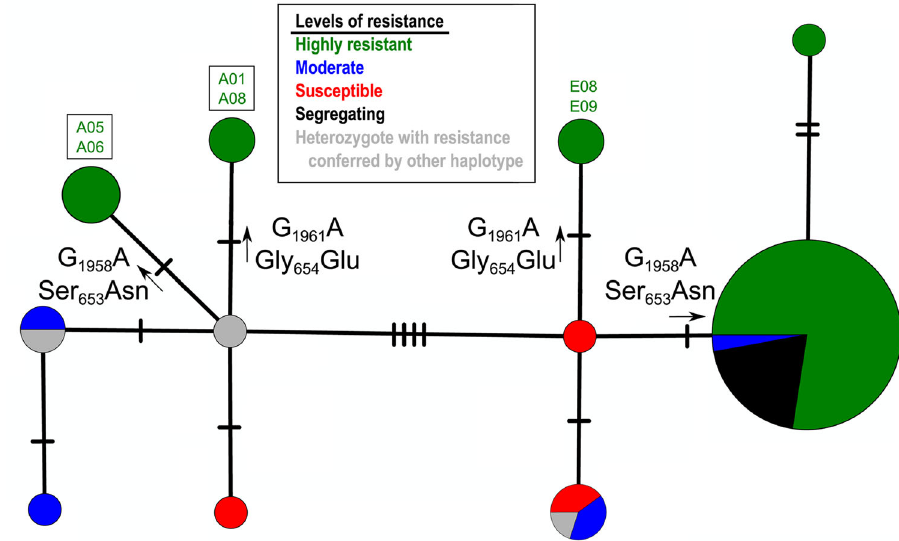
Fig. 5 Haplotype tree of the ALS herbicide resistance locus. Median joining haplotype tree of the ALS herbicide resistance locus from contemporary weedy rice samples. Tree shown is one of four equally parsimonious arrangements (see Supplementary Fig. 6 for alternative topologies). Labeled mutational steps with arrows indicate gain-of-resistance mutations (nucleotide change and corresponding amino acid replacement). Sample names in boxes (A05, A06, A01, A08) are contemporary weed accessions that are not of crop × weed hybrid origin. Sizes of pie chart circles are proportional to haplotype numbers, and colors indicate proportions of herbicide resistance levels.